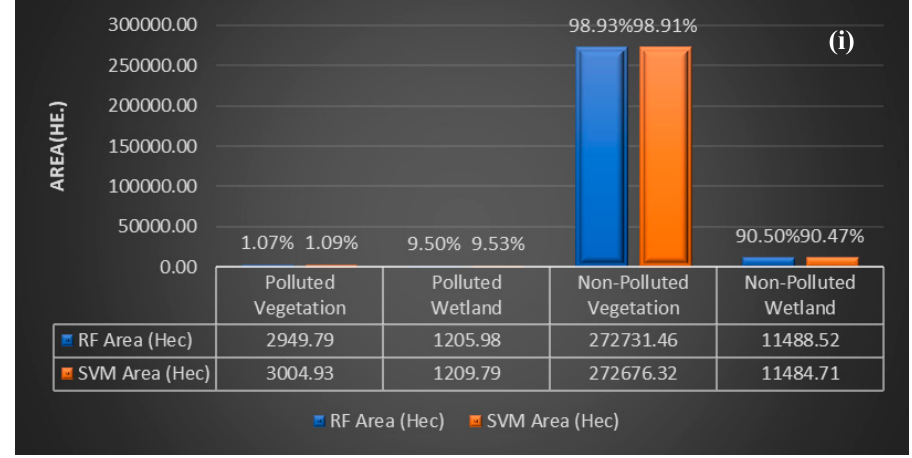
Figure 4. ( a ) Support Vector Machine (SVM)-classified polluted vegetation; ( b ) SVM-classified polluted wetland; ( c ) Random Forest (RF)-classified polluted vegetation; ( d ) RF-classified polluted wetland; ( e ) SVM-classified polluted vegetation for a larger area; ( f ) SVM-classified polluted wetland for a larger area; ( g ) RF-classified polluted vegetation for a larger area; ( h ) RF-classified polluted wetland for a larger area ; ( i ) Quantified area of polluted and nonpolluted vegetation and wetland from SVM and RF of the study area.